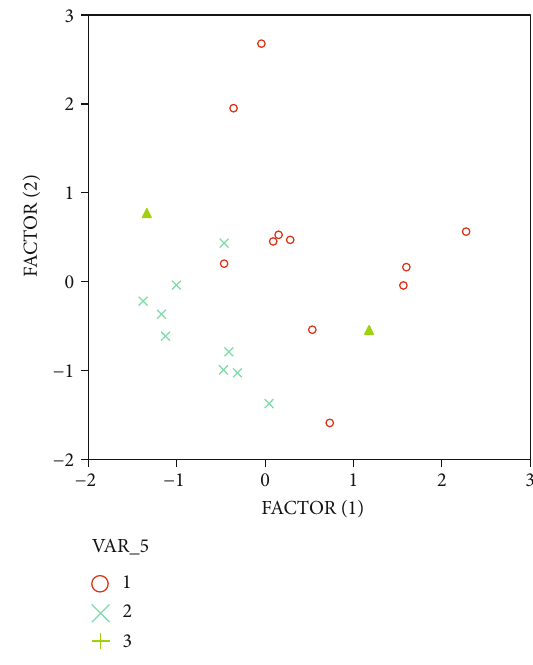
Figure 6: Diagram of factor scores (1, 2, and 3 are the samples of quaternaryaquifer, sandstone, and air way-drainage way,